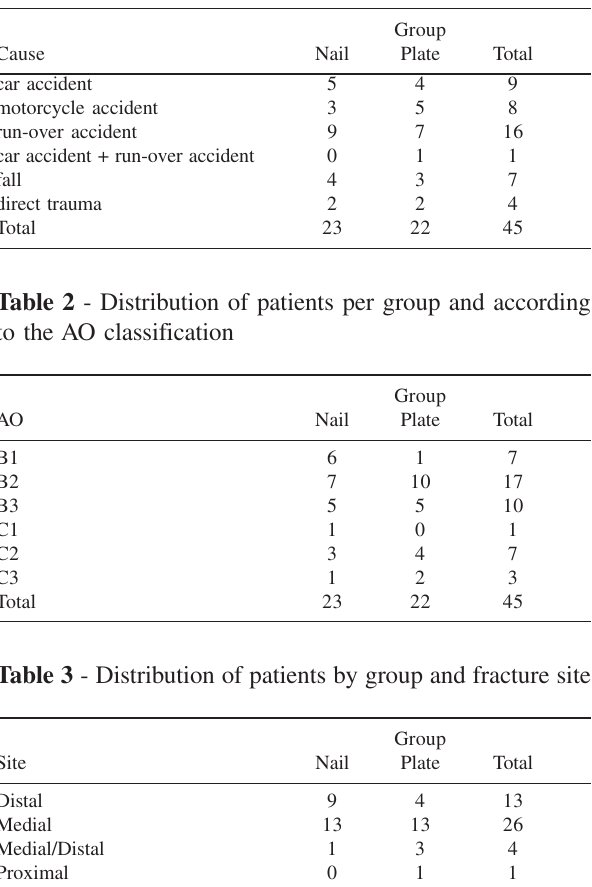
Table 1 - Distribution of patients per group and cause of fracture Cause car